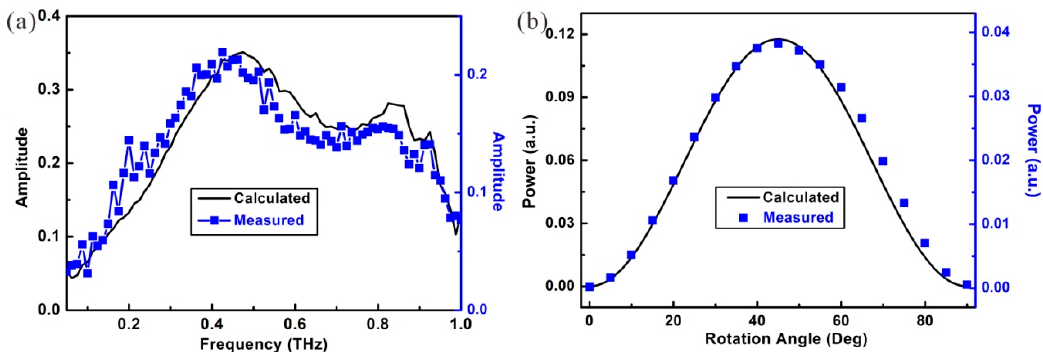
Figure 5. Calculated and measured THz anisotropy in the metamaterial. ( a ) Transmission amplitude vs. frequency for a rotation angle of θ = 45°. ( b ) Power of transmission vs. rotation angle at the frequency of f = 0.4 THz.